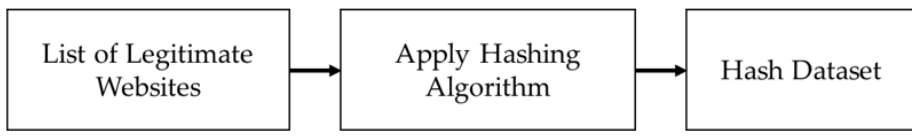
Figure 3. The process of creating the hash datasets.